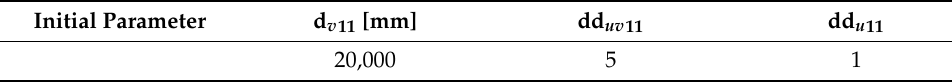
Table 1. The values of the initial parameters of Γ 1 . Initial